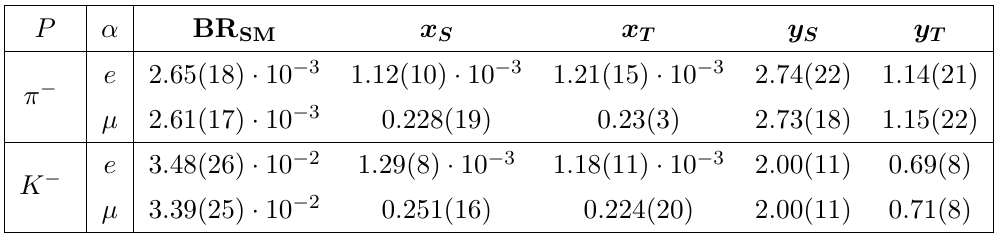
Table 1 . Coefficients of the parametrization in eq. (3.2) obtained using lattice QCD results [15, 16] for the form